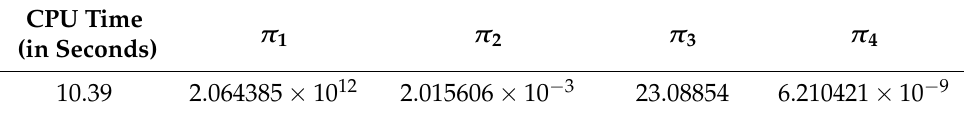
Table 5. Result of implementation of nlstac for pattern (16) taking a tolerance of 10 − 12 , the number of divisions as 50 and [ 0,0.01 ] as the interval where to seek the nonlinear parameter γ .